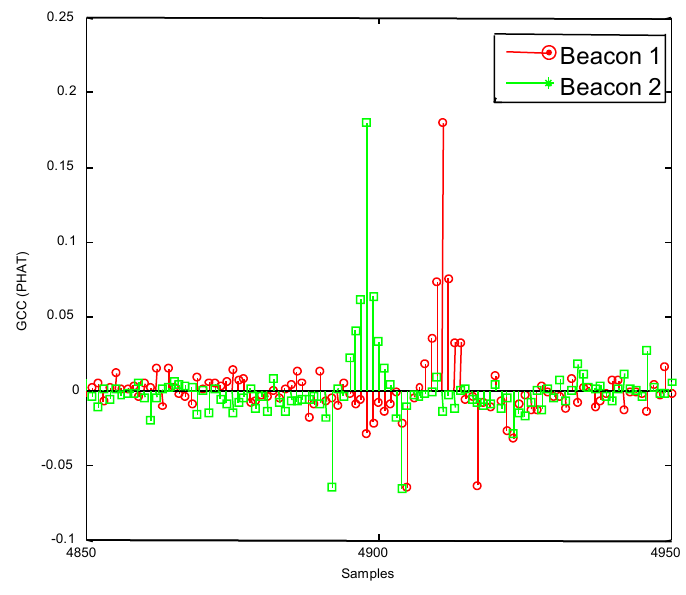
Figure 8. Beacon detection with a signal-noise ratio of 0 dB, by applying generalised cross-correlation (GCC) with PHAT filtering.